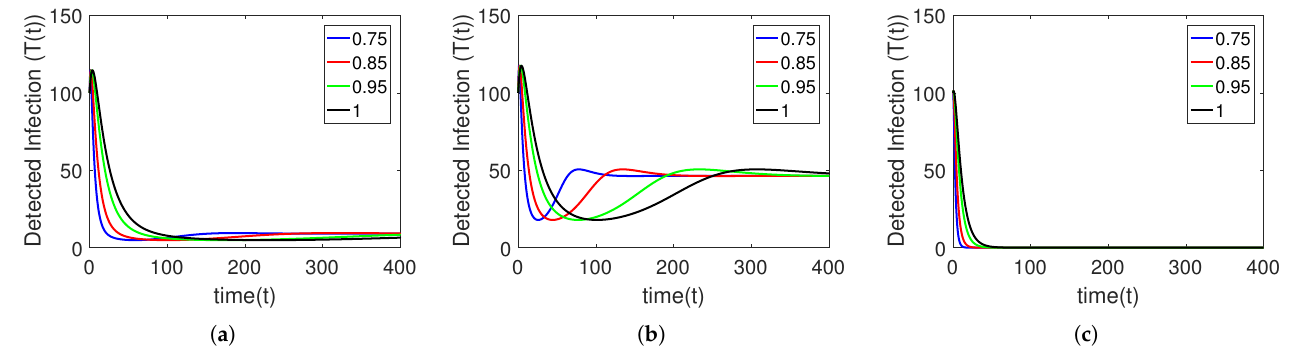
Figure 10. Graphical view ( a – c ) of Detected infected class on different arbitrary orders γ = 0.75, 0.85, 0.95, 1 for initial data and time duration for TB model by taking the value of η = 0.0143,0.143,1.143.